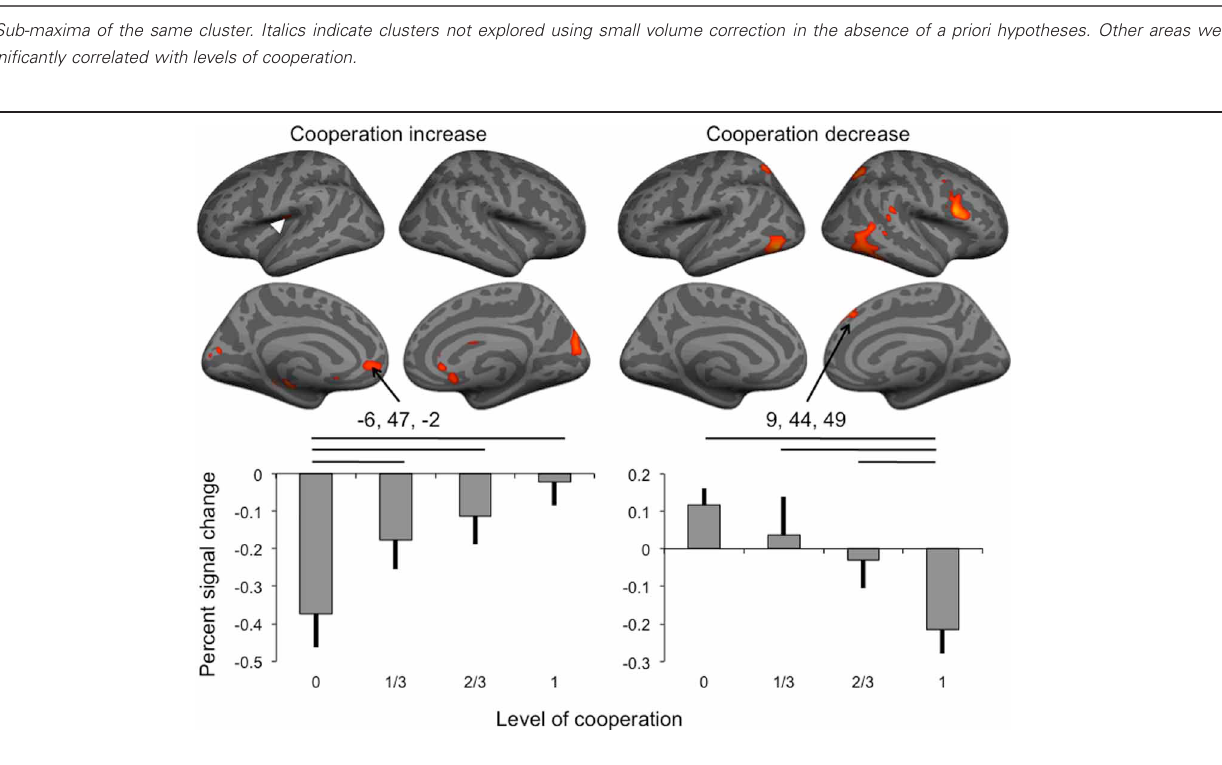
(error bar: standard error) in the anterior cingulate and dorsomedial frontal cortex clusters. Horizontal lines indicate significant pairwise comparisons at p < 0 .